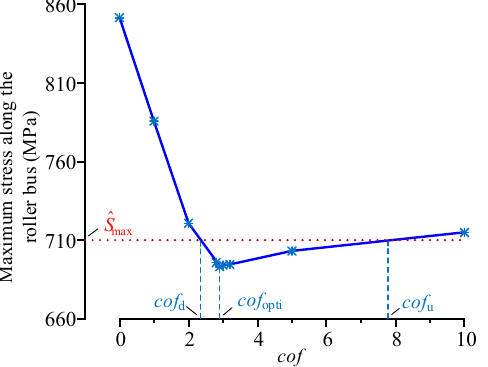
Figure 26. Maximum stress of the roller profile at different crowning parameter cof .